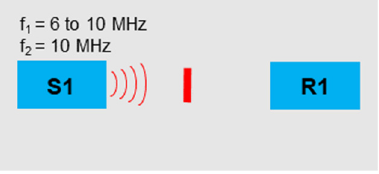
Figure 14. Excitation frequencies: f 1 = 6 to 10 MHz, f 2 = 10 MHz.